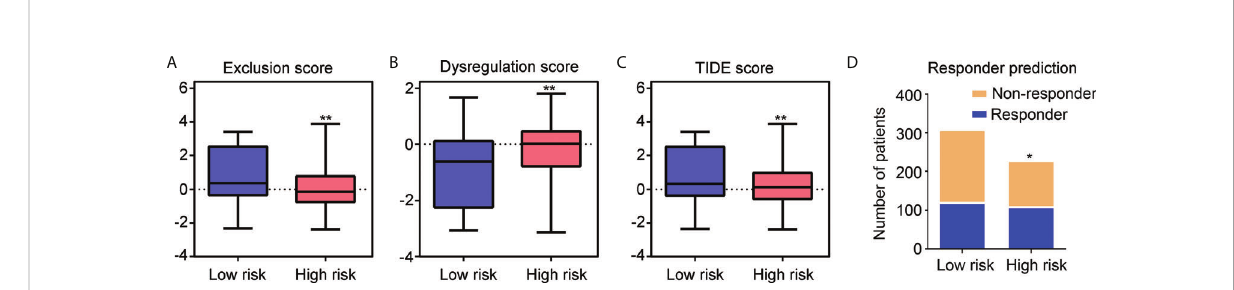
FIGURE 11 Glioma patients with IDH1mt in high-risk group exhibit high responsiveness to ICB therapy. (A) Exclusion score of glioma patients with IDH1mt in high- and low-risk groups. (B) Dysregulation score of glioma patients with IDH1mt in high- and low-risk groups. (C) TIDE score of glioma patients with IDH1mt in high- and low-risk groups. (D) Responders and non-responders among glioma patients with IDH1mt in high- and low- risk groups. *P < 0.05; **P <